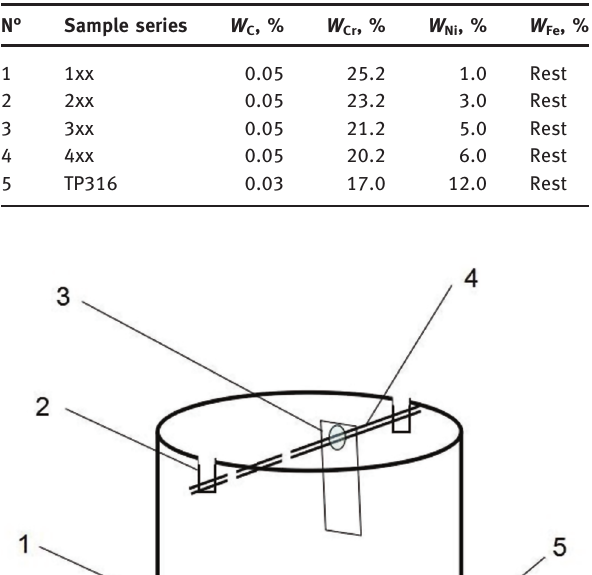
Table 1: Chemical compositions of newly designed materials.